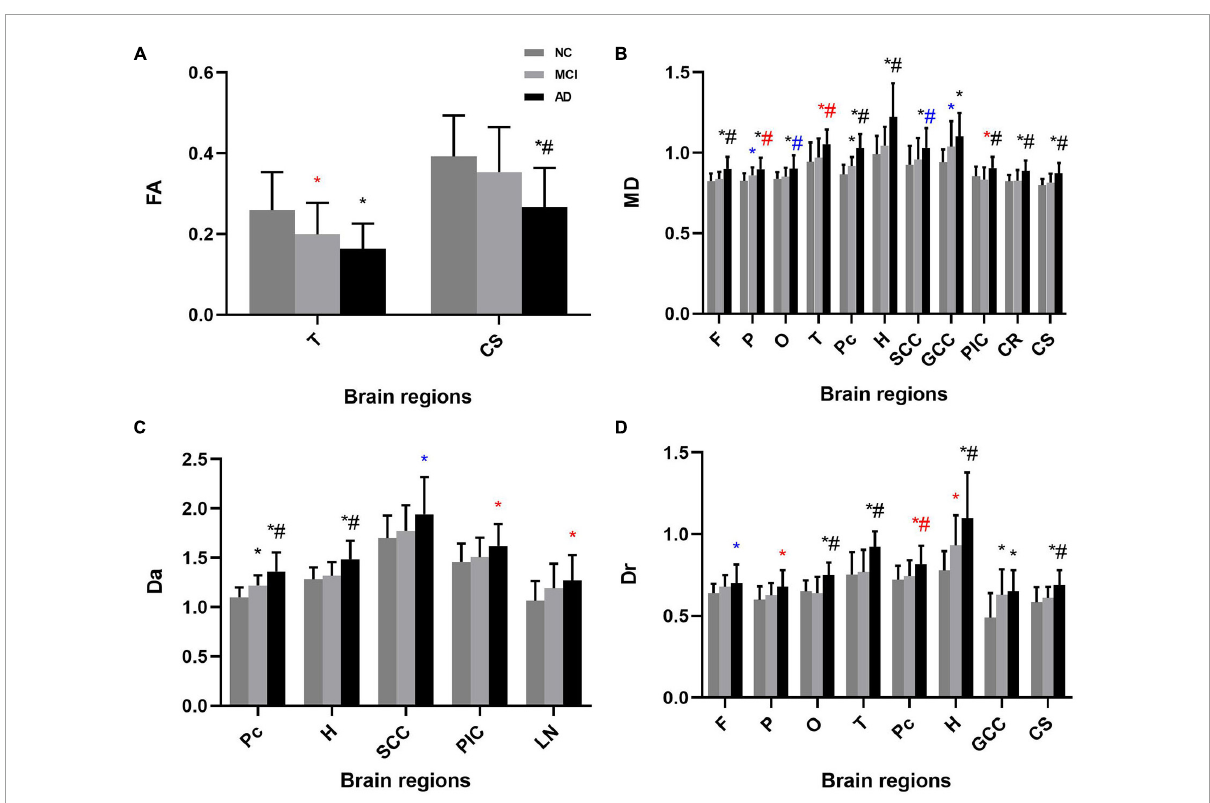
FIGURE3 Mean ( ± standard deviation) diffusivity for each ROI for each study group in both one-way analysis of variance (ANOVA) and analysis of covariance (ANCOVA). (A) FA, (B) MD, (C) Da, and (D) Dr showed significant differences between groups. AD patients had higher diffusivity in most ROIs than the MCI and normal cognition groups. NC, normal cognition; MCI, mild cognitive impairment; AD, Alzheimer’s disease; FA, fractional anisotropy; MD, mean diffusion; Da, axial diffusion; Dr, radial diffusion; F, frontal lobe; P, parietal lobe; O, occipital lobe; T,